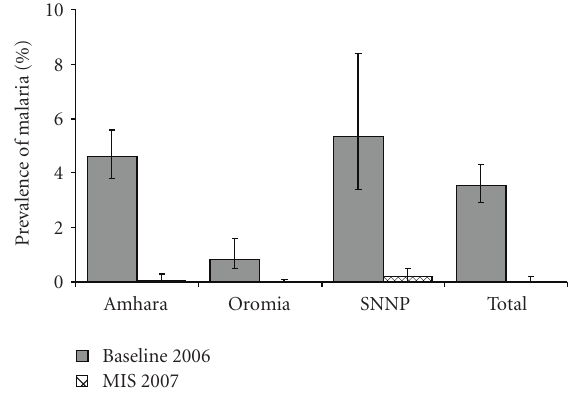
Figure 5: Age adjusted prevalence of malaria by blood slide microscopy, by survey and regional